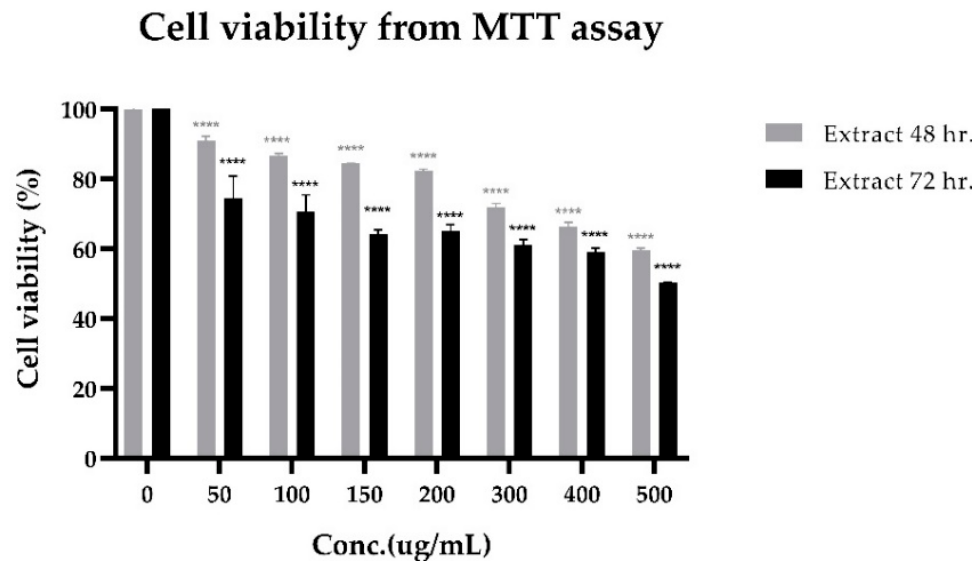
Figure 4. Cell viability (from MTT assay) of PLC/PRF/5 human hepatocellular carcinoma cells treated with lime peel ethanolic extract for 48 h. (grey bars) and 72 h. (black bars). The statistical differences were separately analyzed for limonin and hesperidin by using one-way ANOVA followed by the Bonferroni comparisons test. The symbol **** mean p < 0.0001, compared with the negative control (0.5% DMSO).